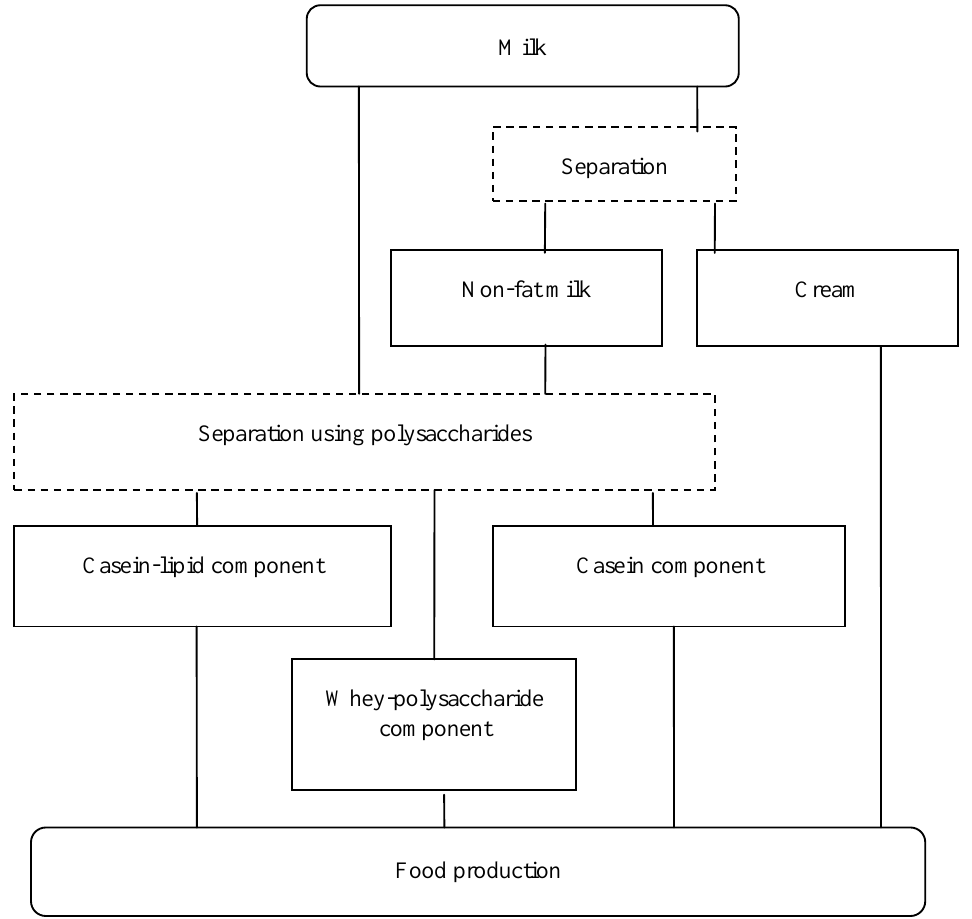
Fig. 6. Schematic diagram of separation of milk by polysaccharides. Table 5. Average physical and chemical values of NCC in comparison with non-fat